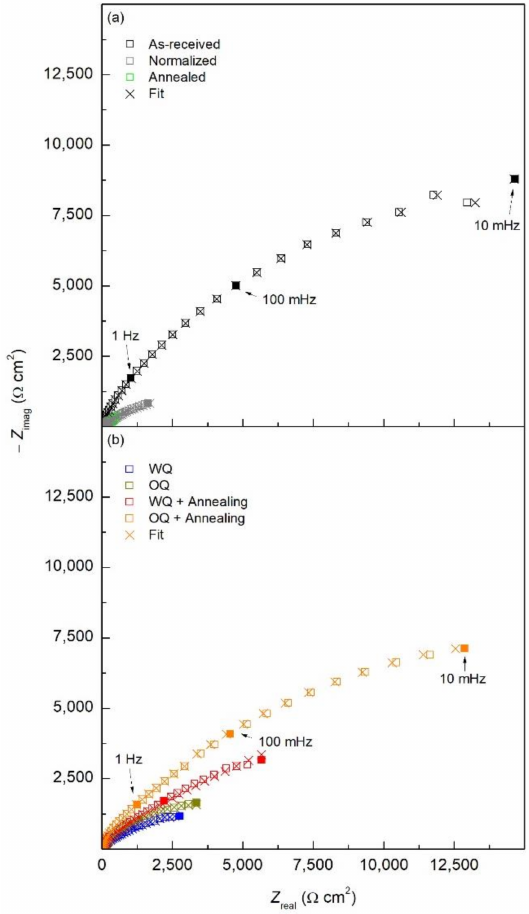
Figure 7. Nyquist plots of the thermomechanical treated CS rebars in FA pore solution containing 0.6 M NaCl: ( a ) slow cooling rate, and ( b ) fast cooling rate.